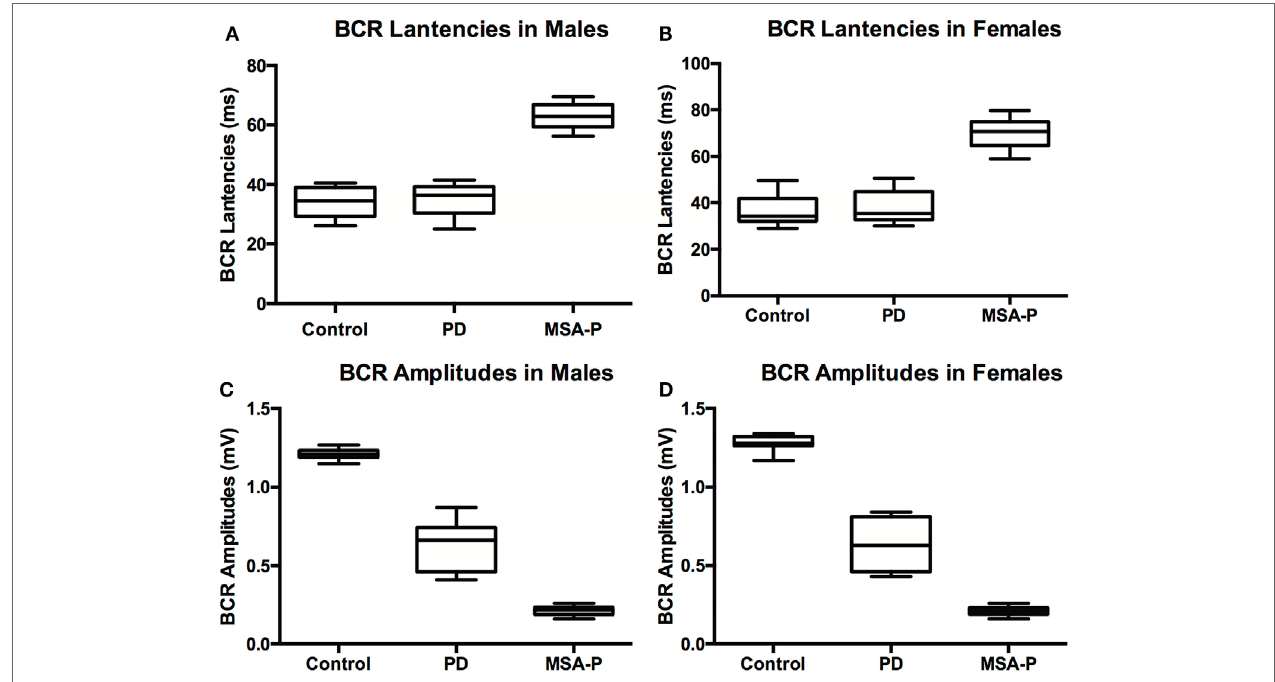
FigUre 1 | Bulbocavernosus reflex (BCR) latencies and amplitudes between multiple system atrophy with predominant parkinsonism (MSA-P), Parkinson’s disease (PD), and control groups in males (a) and females (B) . BCR latencies were not significantly different between control and PD patients, but MSA patients had prolonged latencies compared to the other groups in males (c) and females (D) . BCR amplitudes were significantly lower in MSA-P patients than those in the control group, and amplitudes of PD patients fell in between control and MSA-P